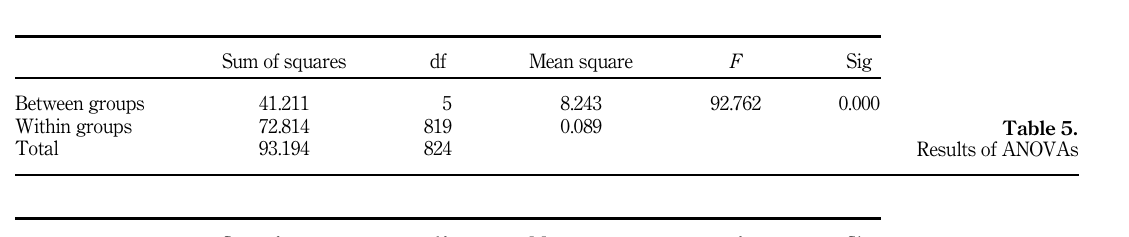
Table 4. Results of ANOVAs